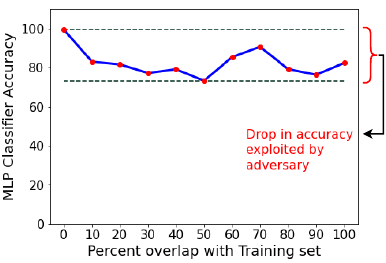
Figure 12: Accuracy of MLP Class-label classifier (trained using dataset with no overlap) over in- creasing ratios of training and test data